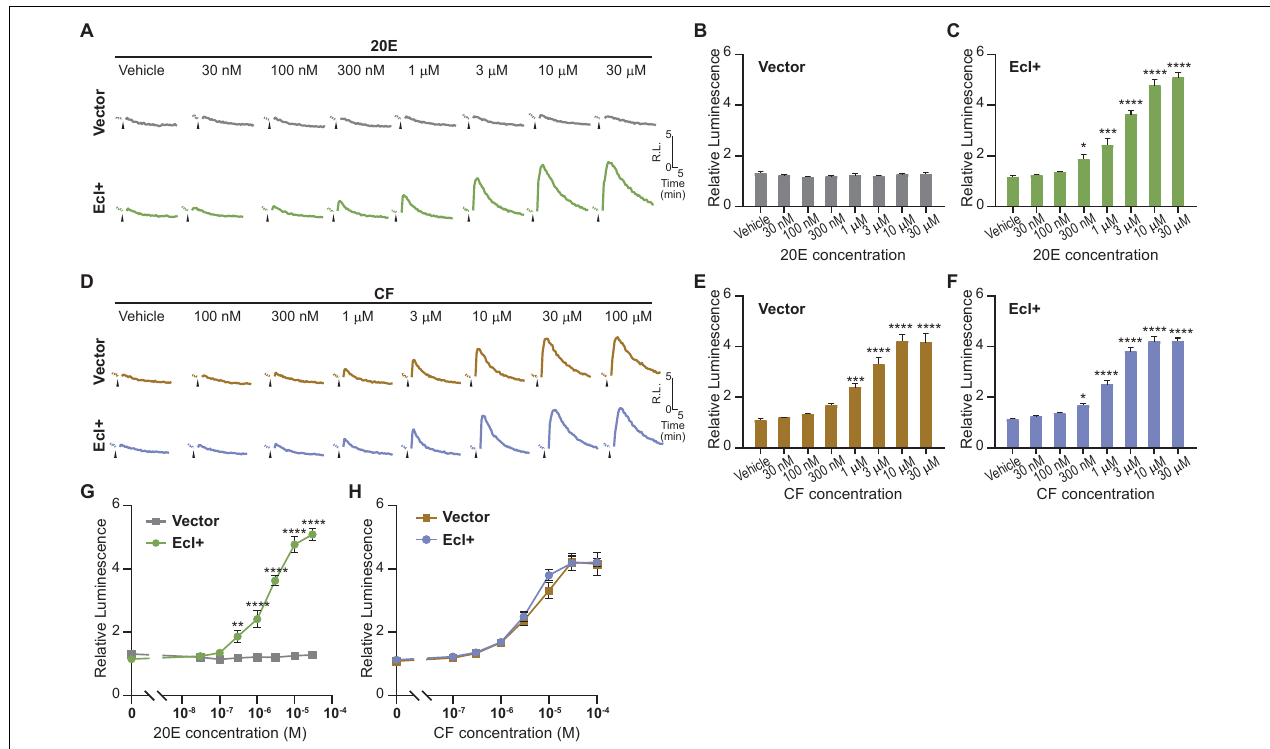
FIGURE 2 | Detection of 20E and CF entry into HEK293T cells using the NanoBiT assay. (A) Mean time-course changes of the relative luminescence in HEK293T cells transfected with RXR-SmBiT and EcR-LgBiT reporters. Either an EcI -containing vector (EcI +) or an empty vector (Vector) was co-transfected, and the luminescence was monitored in real time in response to different doses of 20E. Black triangles indicate the time point when 20E was added to the medium. Data were normalized to the average of the basal luminescence reading immediately prior to treatment (dashed lines). R.L., relative luminescence. (B,C) Maximum relative luminescence in response to different doses of 20E in the Vector (B) or EcI + (C) HEK293T cells. Bars represent means ± S.E.M. ( n = 4). One-way ANOVA analysis identified no significant effect in the Vector cells [ F ( 7 , 24 ) = 1.16, p = 0.362, (B) ], whereas significant effects were observed in the EcI + cells [ F ( 7 , 24 ) = 85.97, p < 0.0001, (C) ]. *, ***, and **** indicate p < 0.05, 0.001, and 0.0001, respectively, from multiple comparisons to the vehicle treatment using Dunnett’s correction. (D) Mean time-course changes of the relative luminescence in HEK293T cells transfected with RXR-SmBiT and EcR-LgBiT reporters. Either an EcI -containing vector (EcI +) or an empty vector (Vector) was co-transfected, and the luminescence was monitored in real time in response to different doses of CF. Black triangles indicate the time point when CF was added to the medium. Data were normalized to the average of the basal luminescence reading immediately prior to treatment